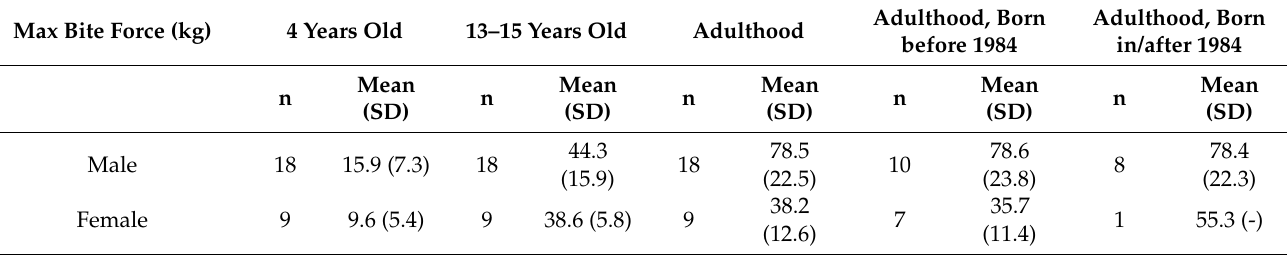
Table 4. Longitudinal change in maximum bite